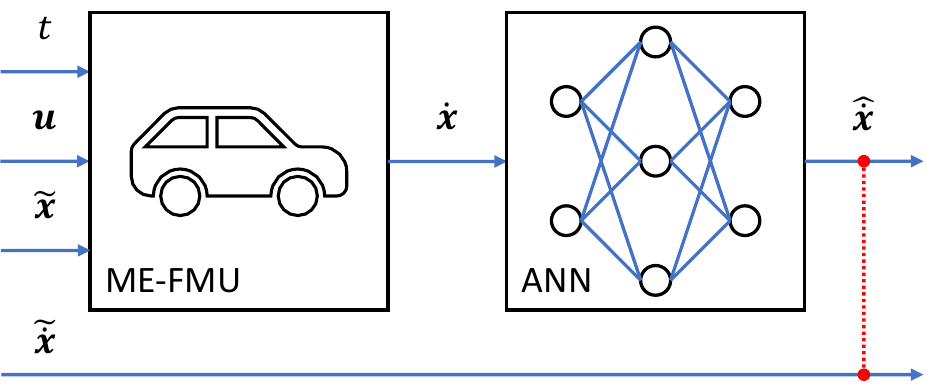
Figure 6. For CCPT, no reference simulation is performed. For a given state trajectory ˜ x ( t ) (e.g., from data), every state is propagated through the FMU and the ANN. As soon as the training goal ˆ˙ x ≈ ˜˙ x (red-dotted) is reached, the NeuralFMU dynamics equal the target dynamic ˜˙ x (e.g., from data). As a result, the later NeuralFMU solution matches the given state trajectory for a perfect known ˜˙ x . The target dynamic ˜˙ x may be estimated by deriving and filtering the given system state ˜ x ( t ) , or it may be known from